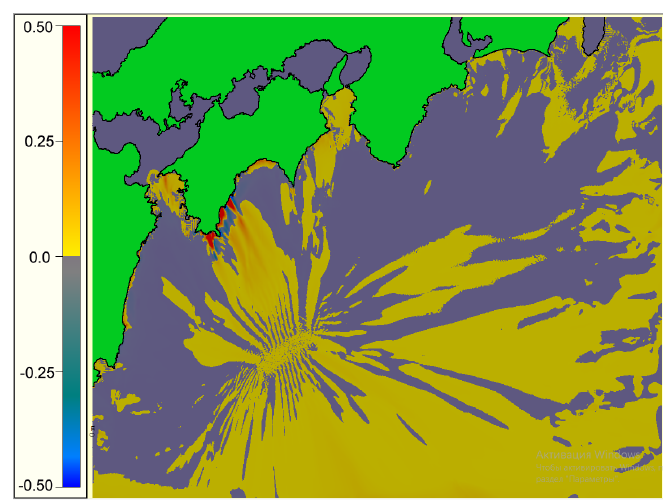
Figure 8. Distribution of the difference between the maximum heights of tsunamis generated by the S0-c source on two different computational grids having longitude grid steps of 0.03 and 0.06 arc degrees. In the north–south direction, these steps are equal to 0.02 and 0.04 arc degrees.